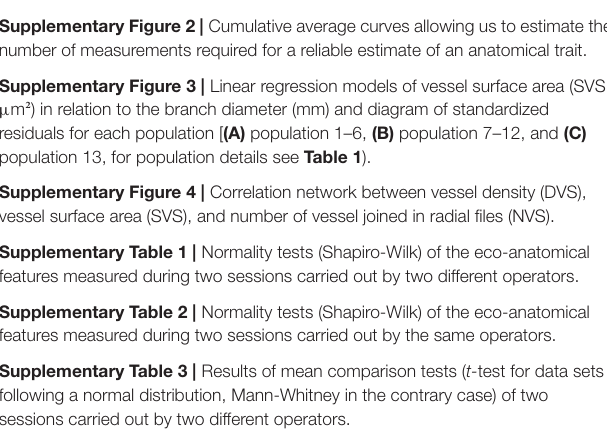
Supplementary Table 3 | Results of mean comparison tests ( t- test for data sets following a normal distribution, Mann-Whitney in the contrary case) of two sessions carried out by two different